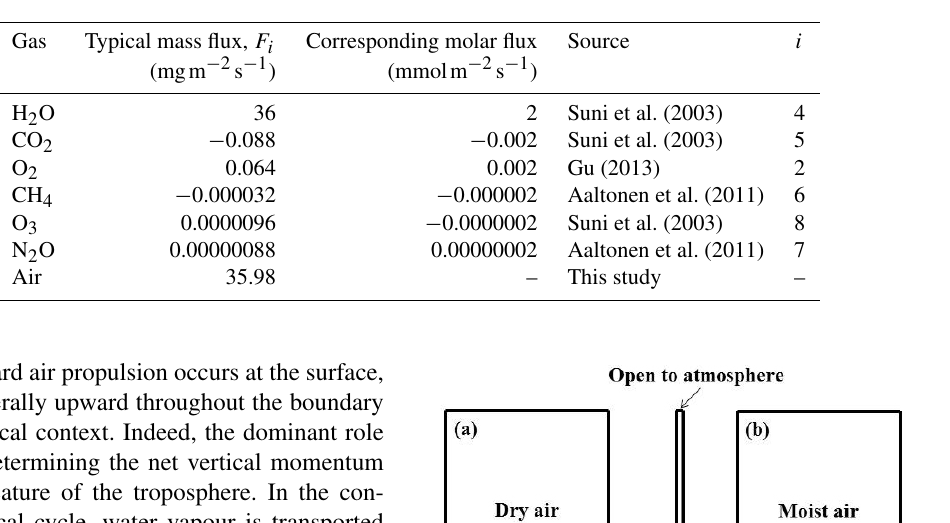
Table 3. The first six air components by their surface exchange scale magnitude, and the net exchange of air as the sum of these flux densities. Representative surface exchanges are taken from the Finnish boreal forest site (Suni et al., 2003; Aaltonen et al., 2011). The O 2 exchange rate assumes 1 : 1 stoichiometry with CO 2 .